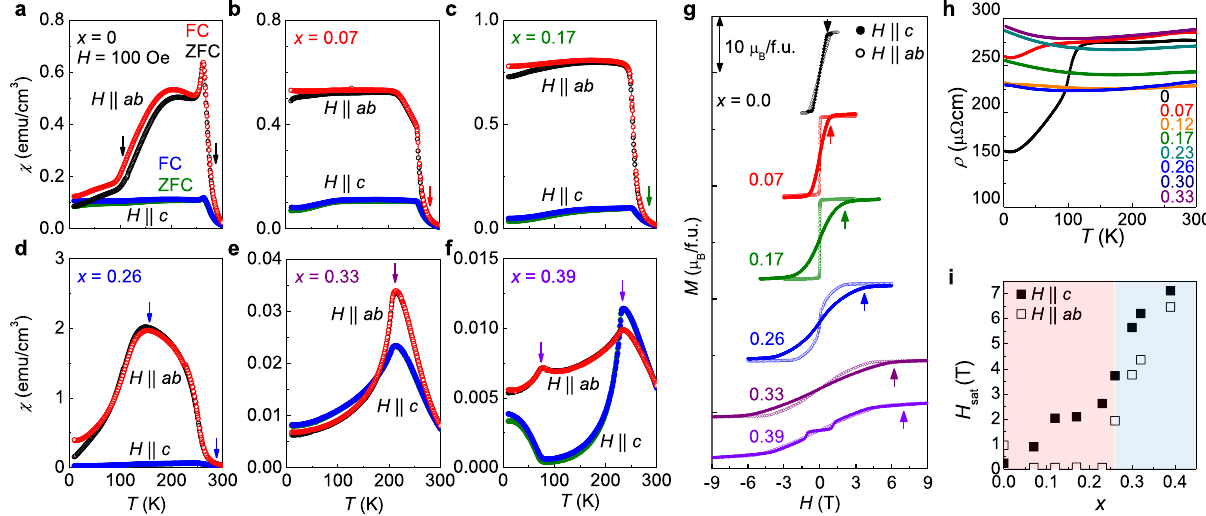
Fig. 2 Doping-dependent magnetic phase diagram of (Fe 1 − x Co x ) 4 GeTe 2 . a – f Temperature-dependent magnetic susceptibility χ ( T ) of (Fe 1 − x Co x ) 4 GeTe 2 (0.0 ≤ x ≤ 0.39), taken during zero- fi eld cooling (ZFC) and fi eld-cooling (FC) under H = 100 Oe with both magnetic fi eld orientations, H ∥ c (solid) and H ∥ ab (open). g Magnetization M ( H ) as a function of magnetic fi eld for (Fe 1 − x Co x ) 4 GeTe 2 (0 ≤ x ≤ 0.39) single crystals, for different fi eld orientations, H ∥ c (solid) and H ∥ ab (open). All the M ( H ) curves were taken at T = 10 K, except those for x = 0.39 taken at T = 100 K. h Temperature-dependent in-plane resistivity ρ ( T ) showing a metallic behavior. i The saturation fi elds H sat for H ∥ c (solid) and H ∥ ab (open) as a function of Co doping x